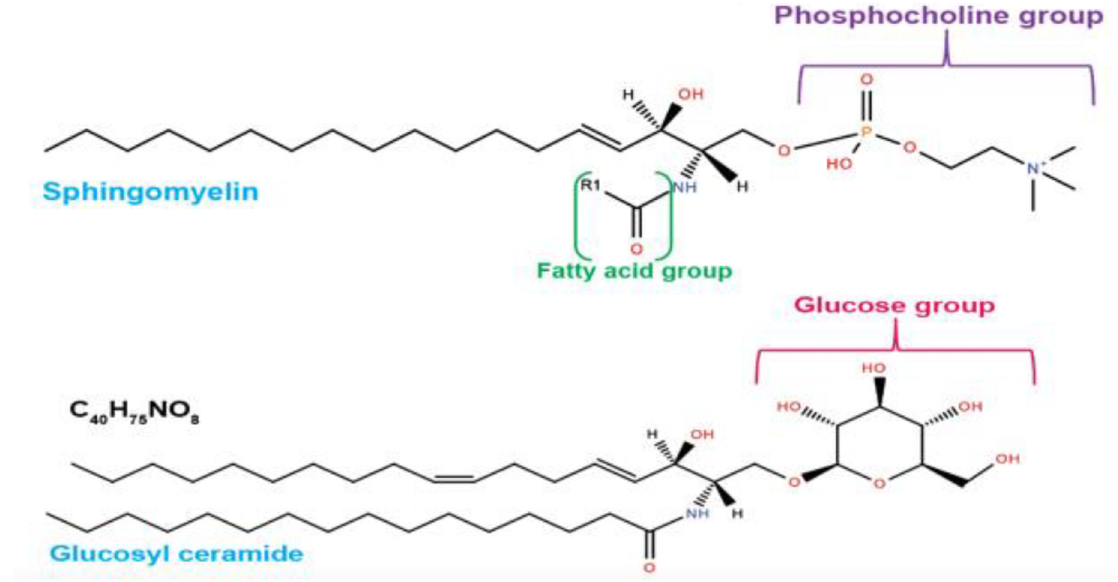
Figure 2. Sphingolipid